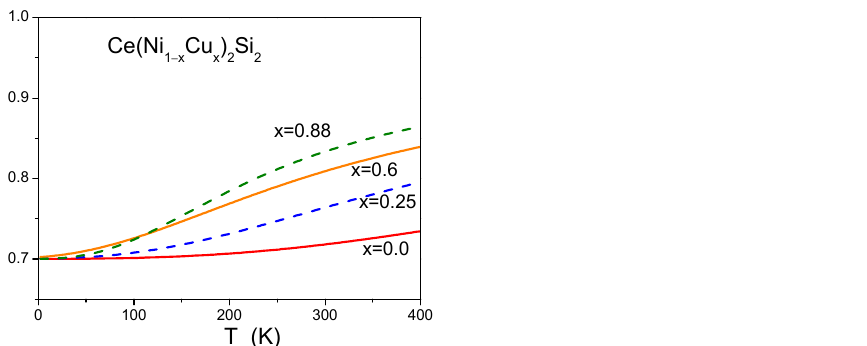
Figure 4. Thermoelectric power of Ce(Ni 1 − x Cu x ) 2 Si 2 as a function of temperature fitted with Equa- tion (5). ( a ) x = 0.25 and ( b ) x = 0.88. See the text for the values of the parameters.